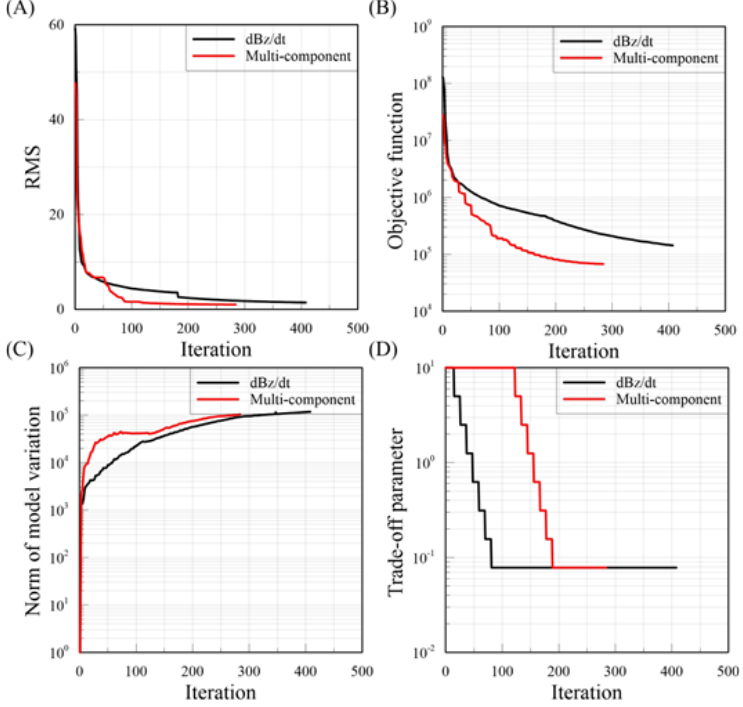
Figure 13. Inversion parameter versus iterations for the sulfide ore body model. ( A ) is the RMS ( B ) is the objective function ( C ) is the norm of model variation and ( D ) is the trade-off parameter.